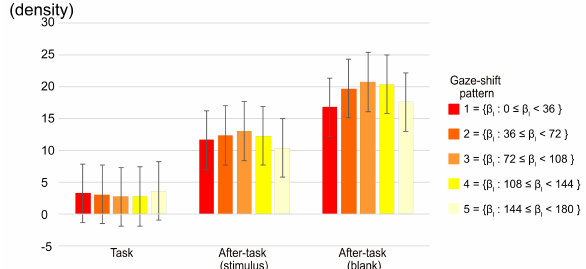
Figure-05. Gaze density of area within 1/20 diagonal of monitor from central point of display. Error bars indicate 95% confidential interval based on Loftus, G. R. and Masson, M. E. (1994)